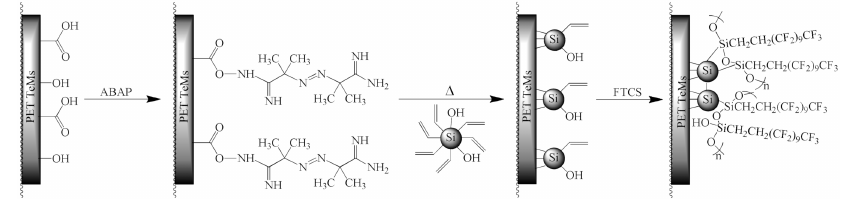
Figure 1. Scheme of PET ion-track membrane